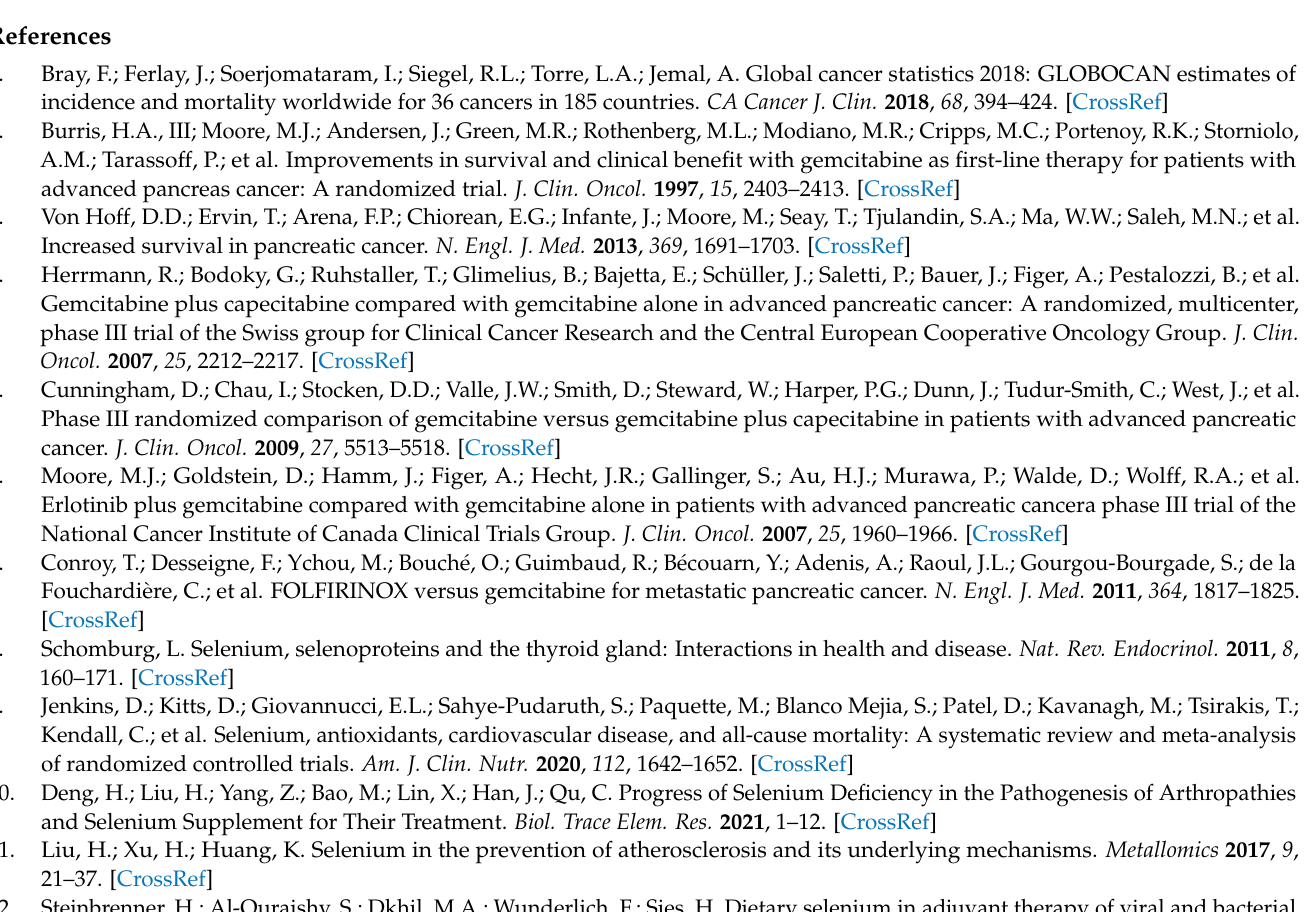
Table S3: Timeseries MuSyC. Table S4: Timeseries HSA. Table S5: 3D Culture MuSyC. Table S6: 3D Culture